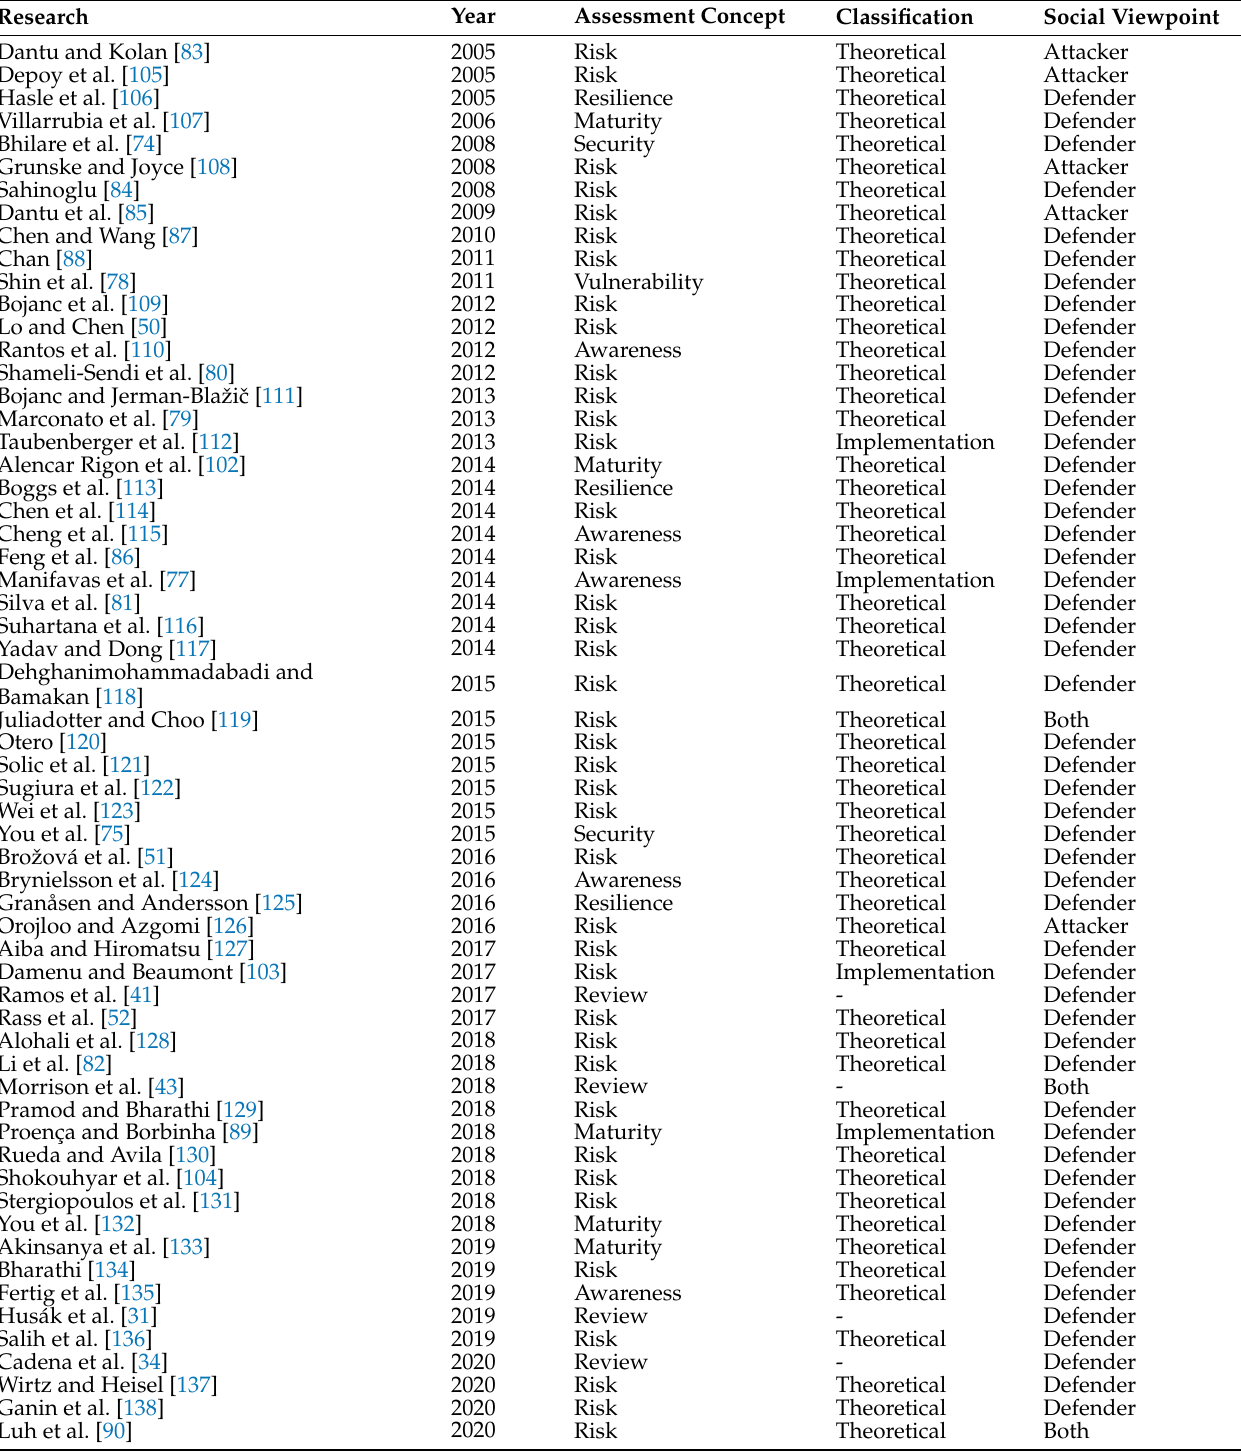
Table A2. The inclusions of our research and a selection of the data items that were presented in this paper. Together with the data items presented in Table A3, they constitute all data items analysed in Section